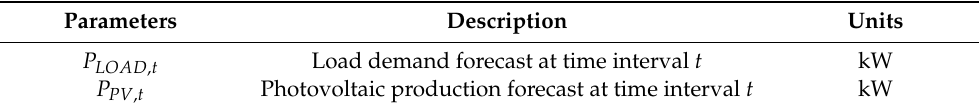
Table 2. List of parameters in the LP model.